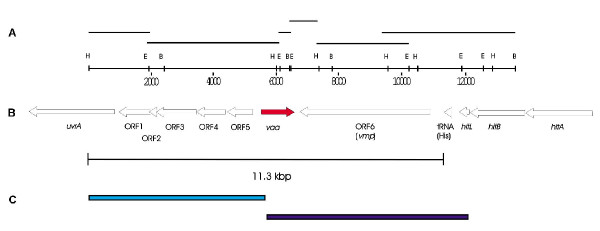
Schematic drawing of the vaa locus of isolate 132. A: Restriction map of the vaa locus showing the cleavage sites for BglII (B), EcoRI (E) and HindIII (H). Fragments amplified by inverse PCR are shown as thick lines above the restriction map. B: Open reading frames of the vaa locus. The vaa gene is shown as a red arrow and show opposite transcriptional direction compared to the other ORFs. C: The PCR products amplified from isolate 132 are shown in cyan (upstream fragment) and purple (downstream fragment).